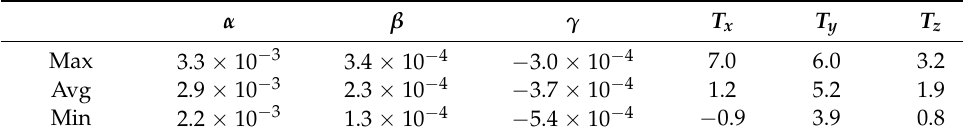
Table 2. ICP point-to-plane registration results.